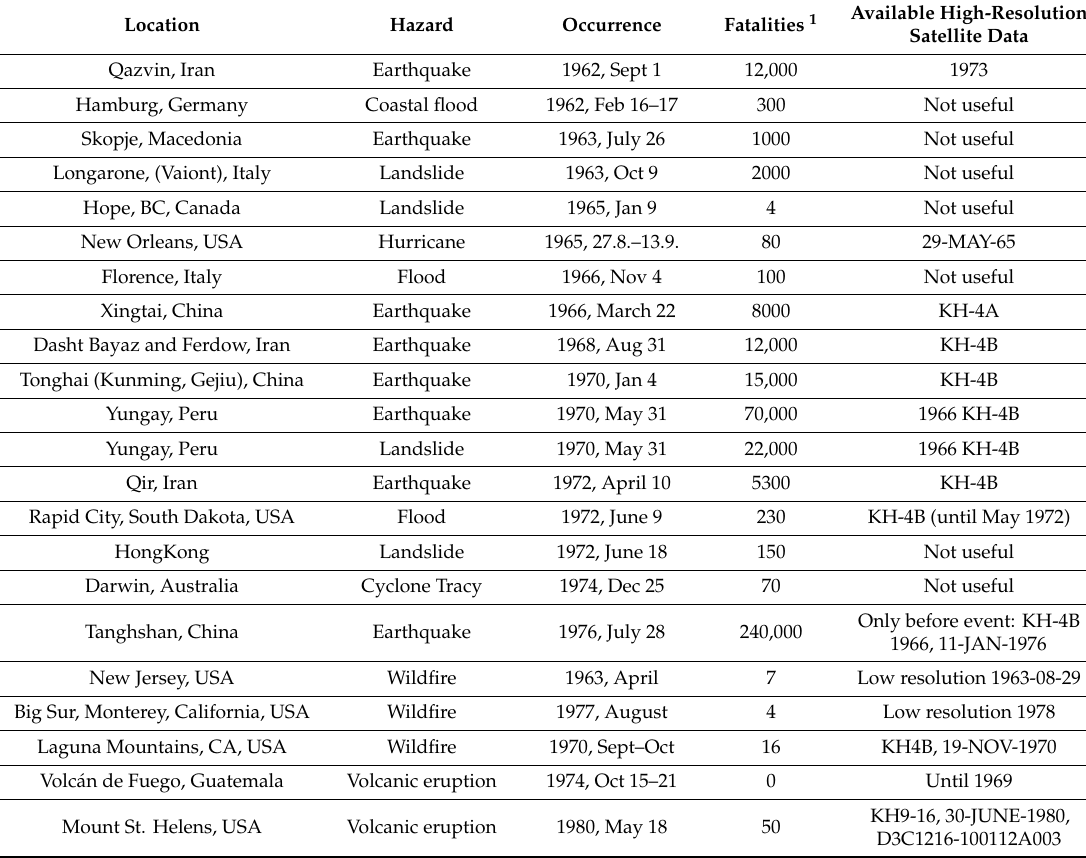
Table 2. List of major disaster events between 1962 and 1984 and results of screening for available high-resolution CORONA images (based on information by USGS, DESINVENTAR and web